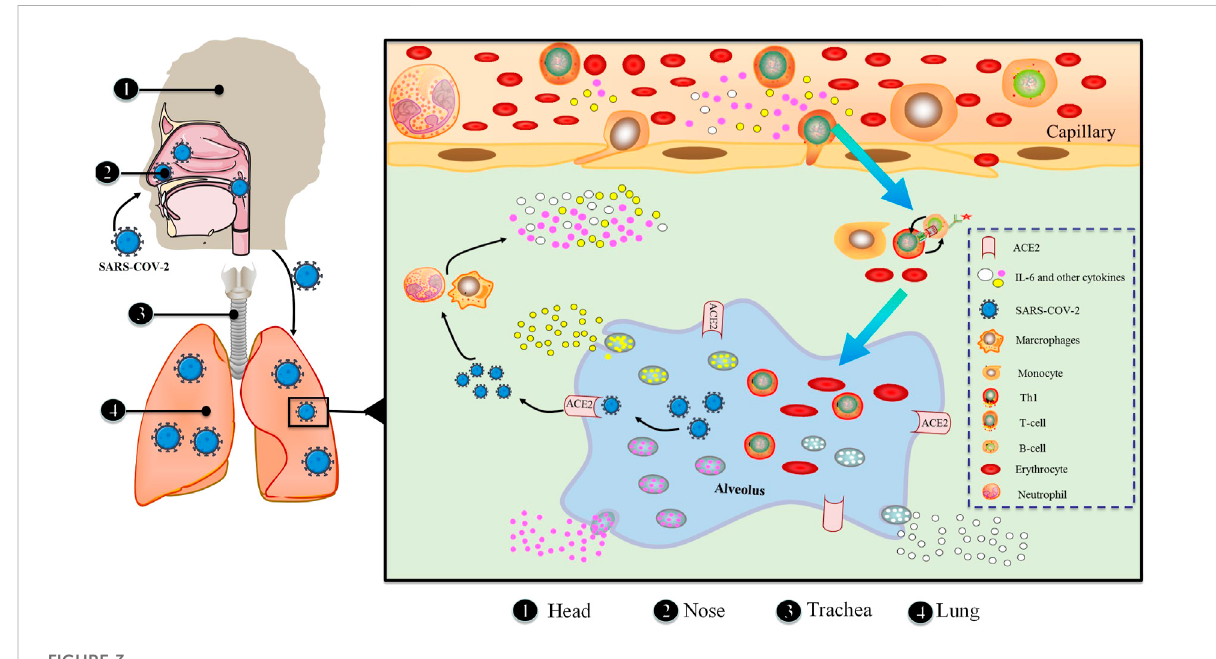
Macro and micro aspects of SARS-CoV-2 invading respiratory system.